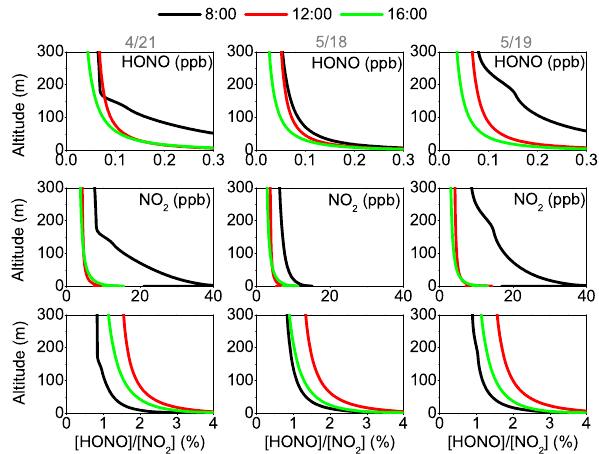
Fig. 8. Modeled vertical profiles of daytime HONO (upper panel), NO 2 (middle panel) and HONO/NO 2 ratios (lower panel) at 08:00, 12:00, and 16:00CST on 21 April, 18 May, and 19 May. Results are from model runs with photolytic HONO sources at the ground and on aerosol.